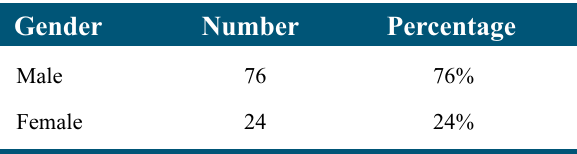
Table 1: Gender wise distribution